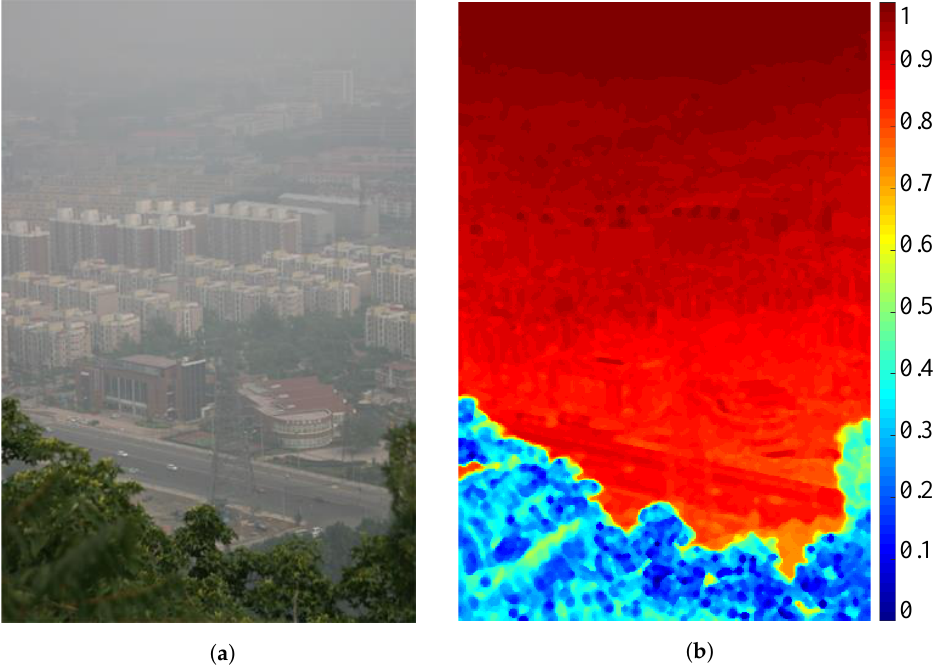
Figure 3. Illustration of haze density estimation. ( a ) Hazy image and ( b ) its corresponding map depicting the local haze density